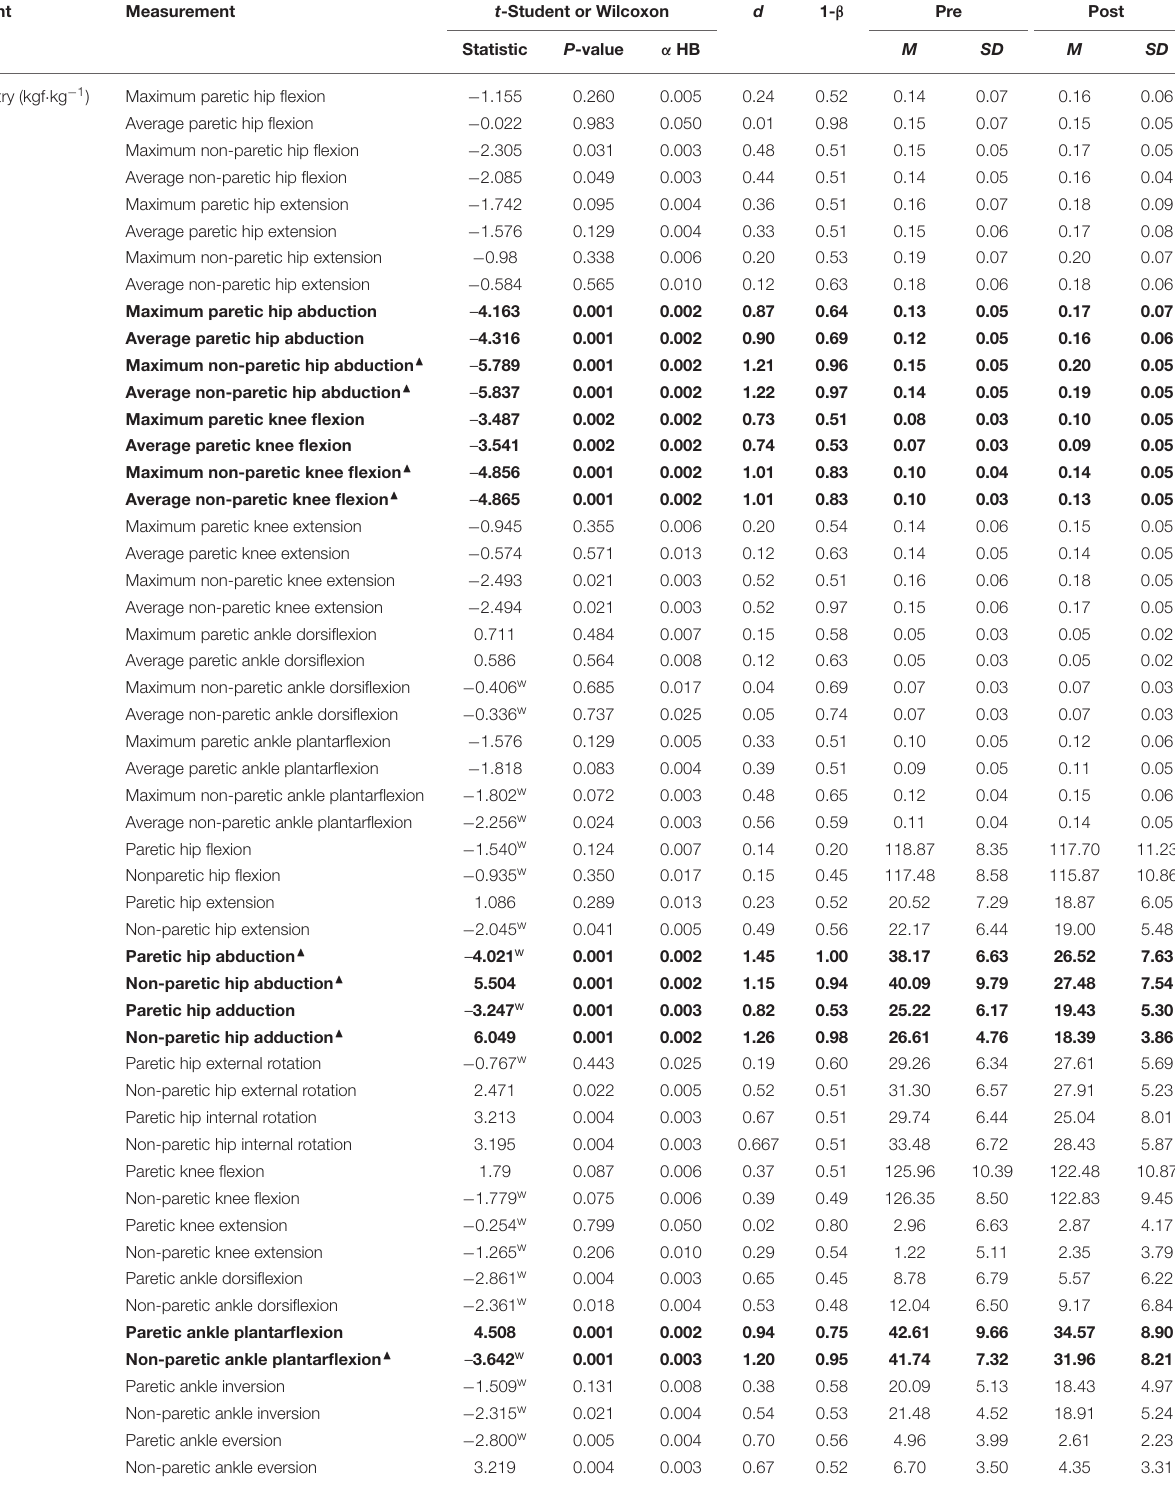
TABLE 1 | Pre-therapy vs. post-therapy comparative statistical